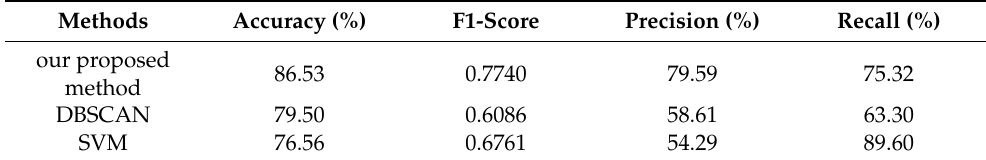
Table 4. Accuracy of different results extracted by different